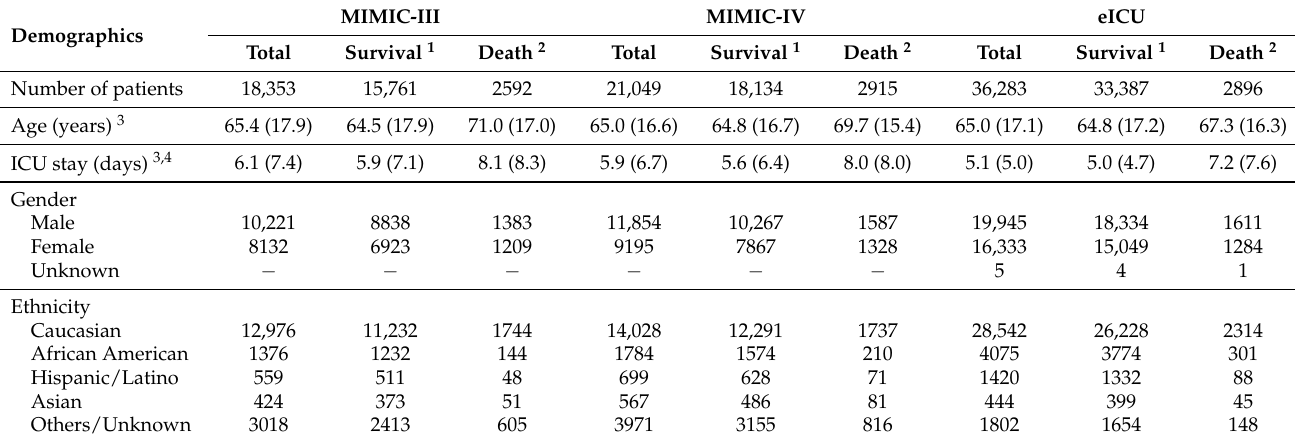
Table 1. Demographics for our study cohorts derived from the MIMIC-III, MIMIC-IV, and eICU databases.